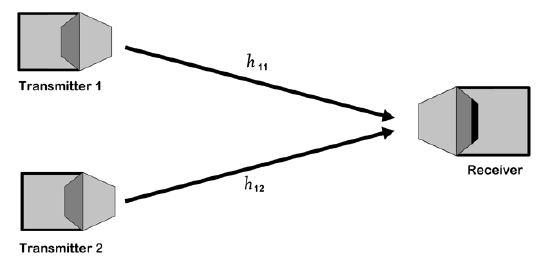
Figure 1. MISO System (2 ×